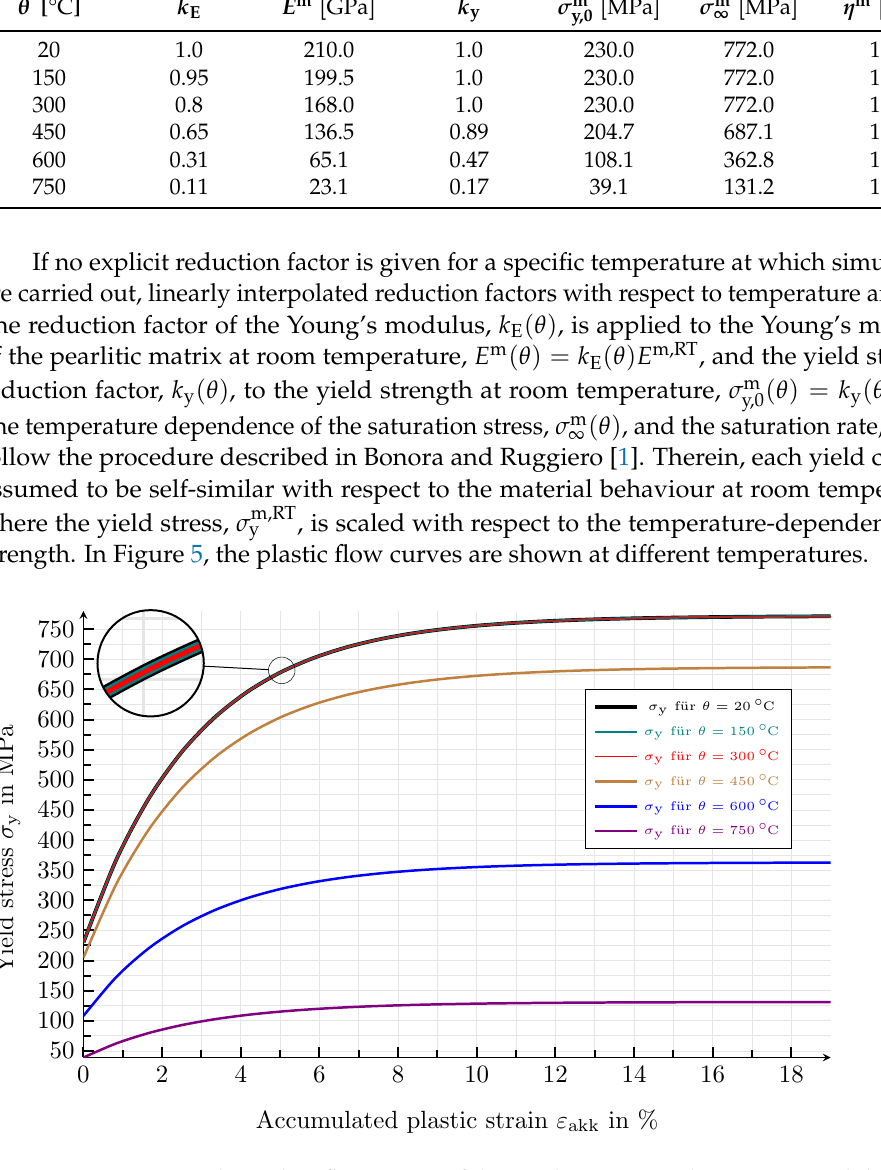
Figure 5. Temperature-dependent flow curves of the pearlitic matrix. The Young’s moduli and the yield strengths decrease at higher temperatures. According to Bonora and Ruggiero [1], all flow curves are self-similar to the material behaviour at room